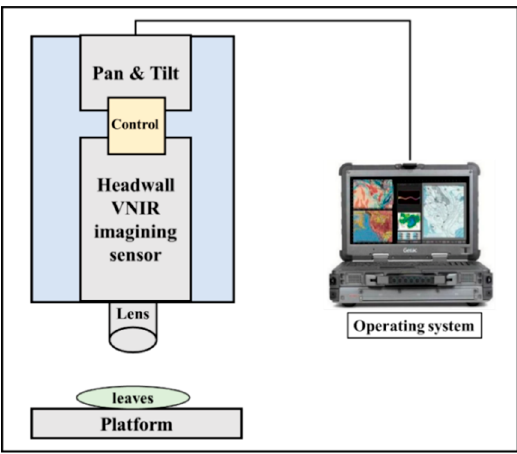
Figure 1. A schematic diagram of the Headwall hyperspectral imaging.